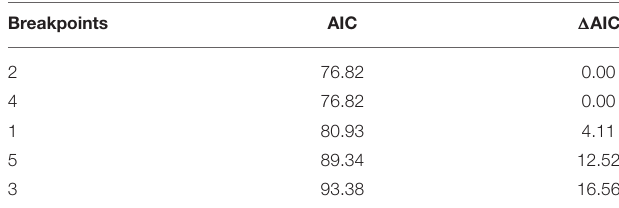
TABLE 4 | Model selection statistics for the segmented model to identify the preferred and accessible prey of